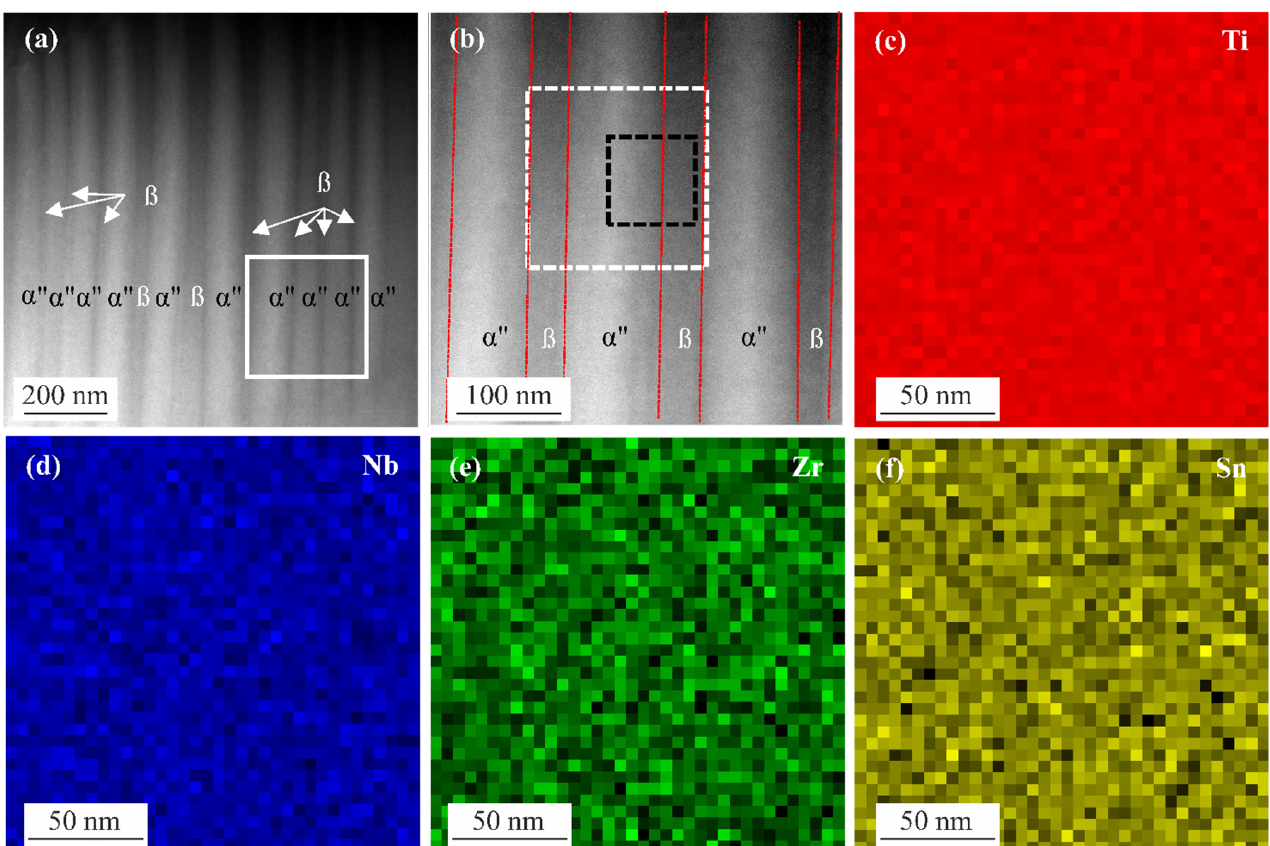
Figure 4. ( a ) HAADF STEM image of the as-built specimen, ( b ) HAADF STEM image of the white square region in ( a ), brighter laths are α″ martensite phase, while the surrounding area is the β matrix, red, dashed lines demarcate the boundary between α″ martensite and β phase; EDS maps from the white, dashed square in ( b ) and chemical distribution of ( c ) titanium, ( d ) niobium, ( e ) zirconium, and ( f ) tin.